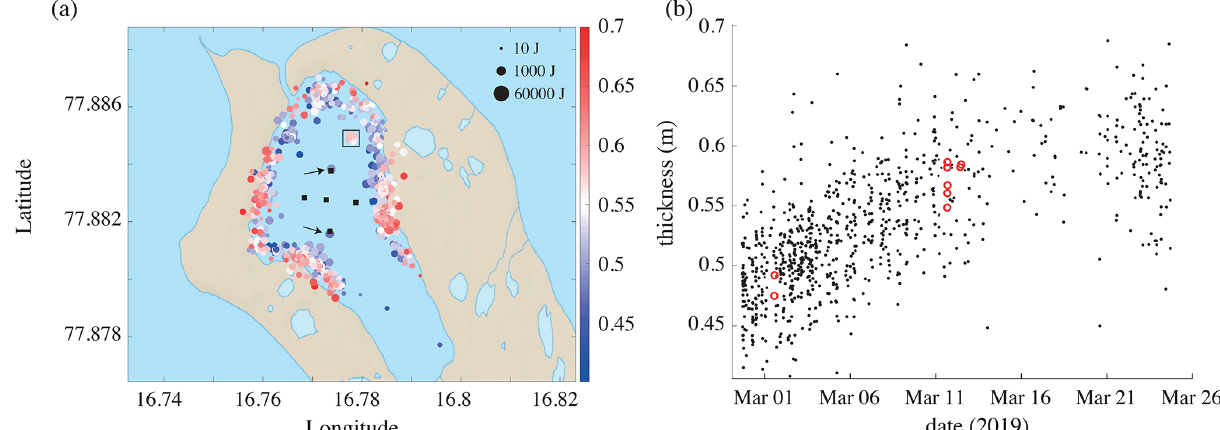
Figure 7. (a) Map of the position of the inverted icequakes. The color bar indicates the corresponding ice thickness (with bounds on the thinnest and thickest values found). This thickness represents an average value along the paths between the icequake source and the five geophones. The size of the circles is proportional to the icequake energy. The black arrows indicate the position of the vertical impulsive sources, and the black square is that of the horizontal impulsive source. (b) Ice thickness versus date, obtained from icequake inversions (black dots) and from waveforms with anthropogenic sources (red circles). The squares indicate values found by drilling the ice. We note a sharp increase in thickness during the first 2 weeks of deployment, followed by a stabilization during the remaining days, which is consistent with the rise in temperatures shown in Fig. 5.